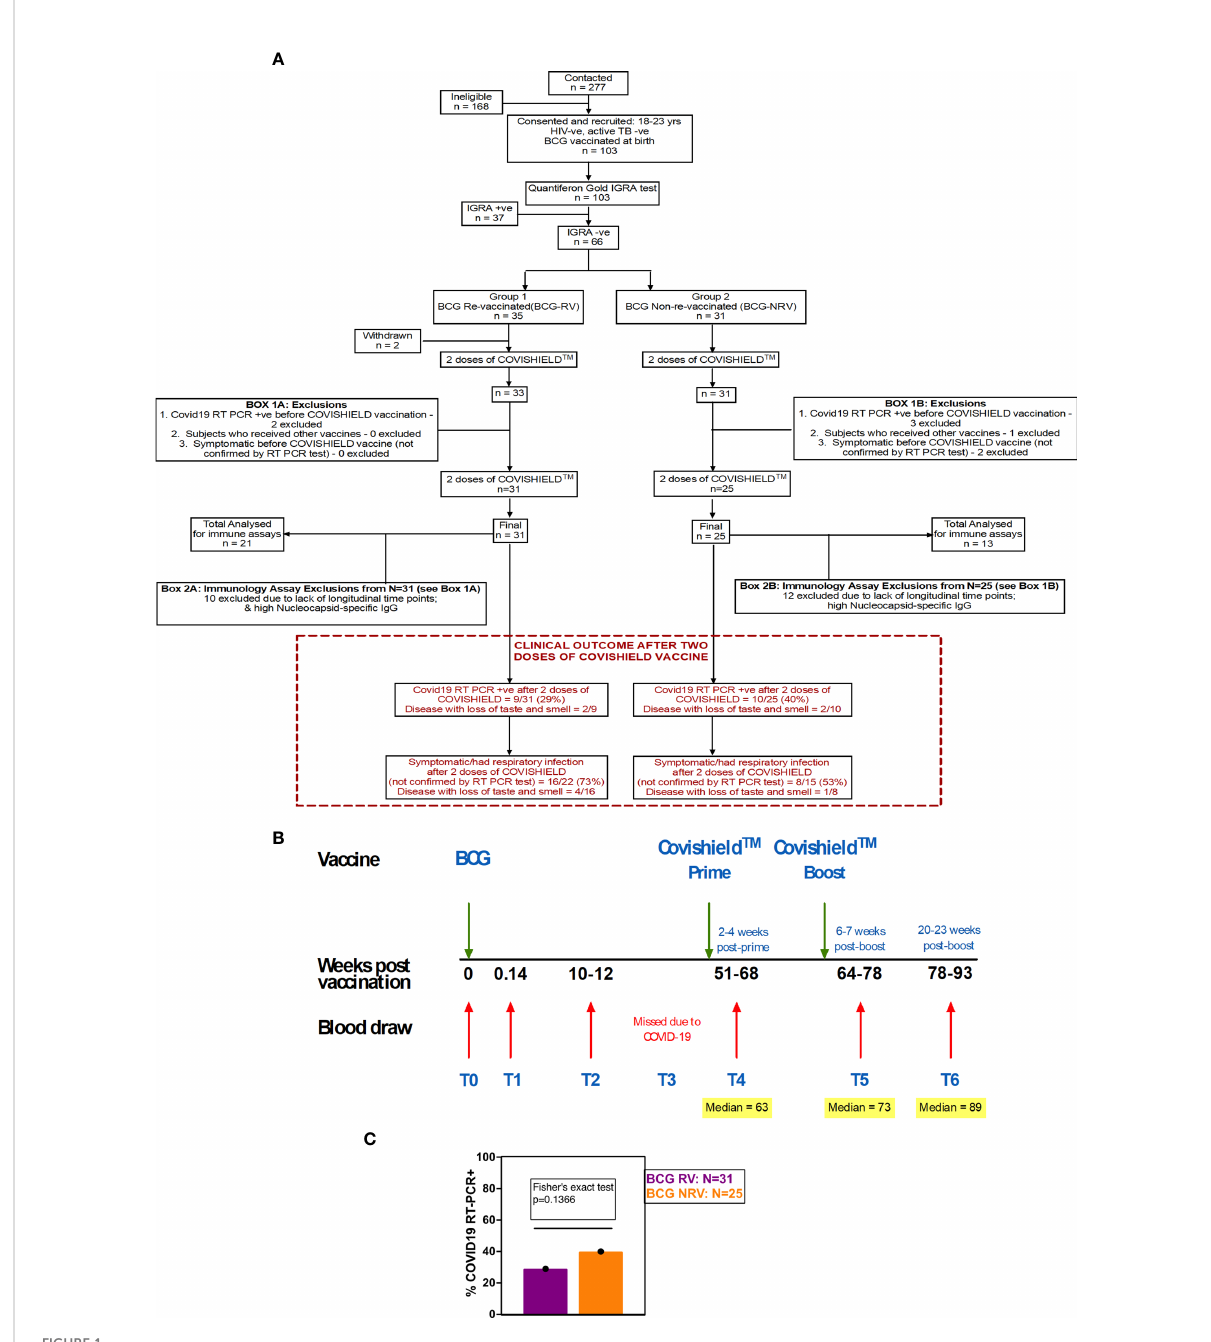
FIGURE 1 Overall study design. (A) CONSORT fl ow diagram of participant recruitment and enrolment. (B) A diagrammatic representation of study design, including schedule of BCG and COVISHIELD ™ vaccination and blood draw. Group 1 received BCG at day 0 (T0) and then both groups were vaccinated with 2 doses of COVISHIELD ™ vaccine (Prime and Boost). Time points for immunization with BCG and COVISHIELD ™ are shown by green arrows, and the 6 blood sampling time points (T0 – T6) are indicated by red arrows for all groups. (C) Clinical Questionnaire Outcome is shown in red box with bar graph of proportionality data of COVID19 RT-PCR positive BCG RV and BCG NRV